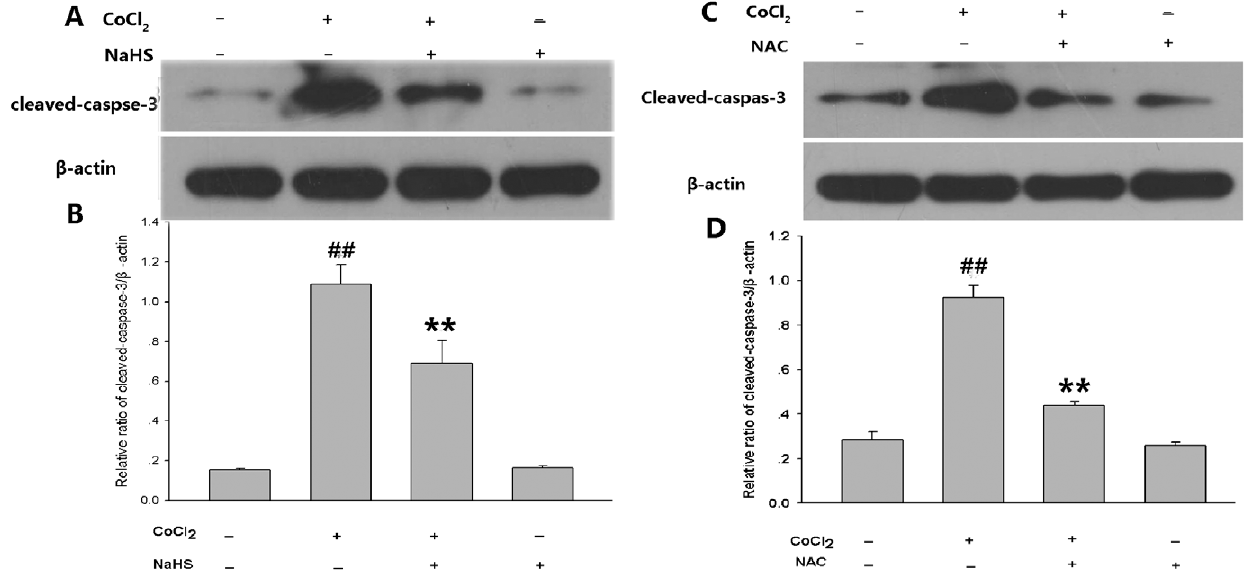
Figure 11. H 2 S and NAC suppressed CoCl 2 -induced expression of cleaved-caspase-3. (A) PC12 cells were preconditioned with 400 m mol/L NaHS for 30 min before exposure of cells to 600 m mol/L CoCl 2 for 9 h; (B) Denstiometric analysis for the results in (A). (C) PC12 cells were preconditioned with 500 m mol/L NAC for 60 min before exposure of cells to 600 m mol/L CoCl 2 for 9 h. (D) Denstiometric analysis for the results in (C). Data are presented as the mean 6 SE from independent experiments performed in triplicate. ## P , 0.01 compared to the control group, ** P , 0.01 compared to the CoCl 2 group.